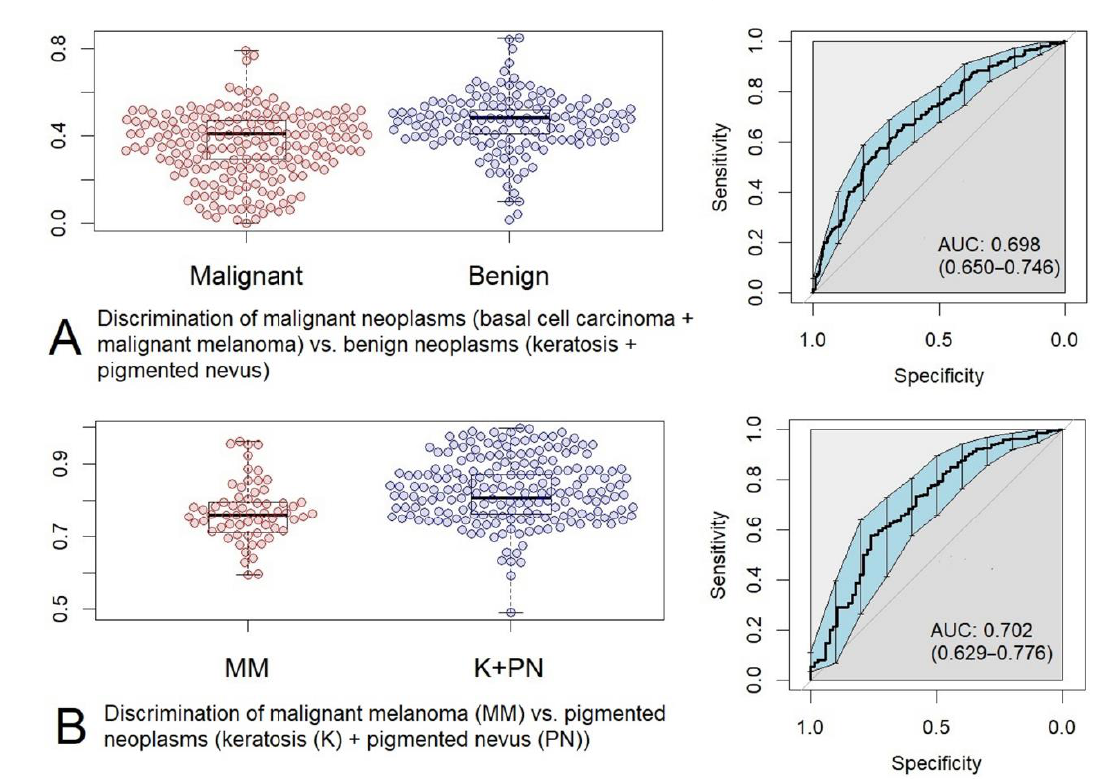
Figure 8. Box-plot diagrams and ROC-curves of predicted values obtained as a result of logistic regression: ( A ) malignant neoplasms (basal cell carcinoma + malignant melanoma) versus benign neo- plasms (keratosis + pigmented nevus), ( B ) malignant melanoma (MM) versus pigmented neoplasms (keratosis + pigmented nevus). Table 1. The significance values ( p -values) for component concentration calculated at the first step of logistic regression. The p -values for the coefficients indicate whether these relationships are sta- tistically significant. If the p -value for a variable is less than the significance level of 0.05, this vari- able is statistically significant. Bold type in the table indicates cases of binary logistic regression. Malignant vs. Benign MM vs. K + PN